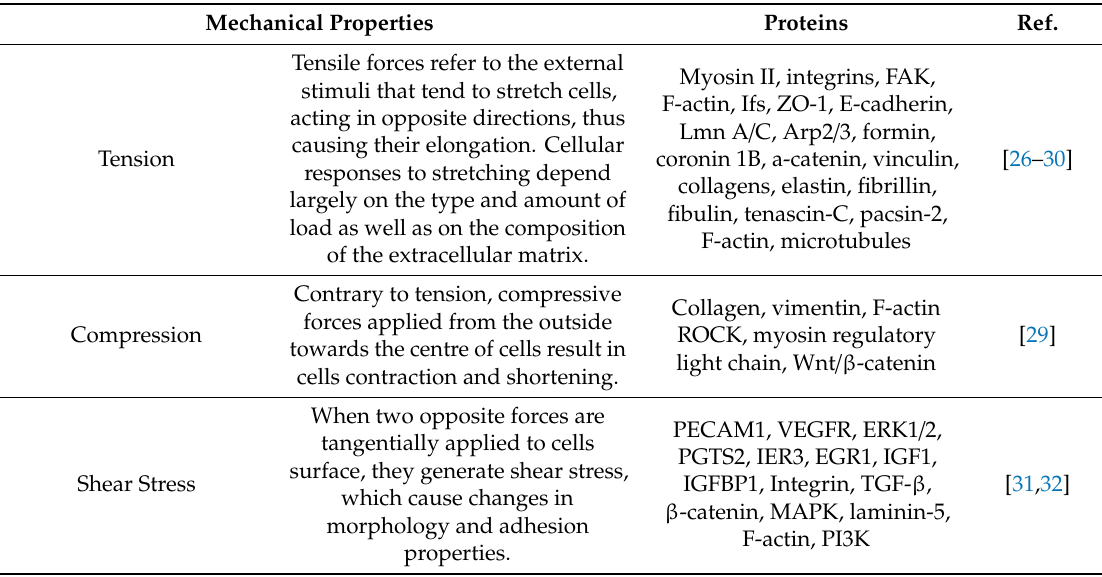
Table 1. Mechanical properties and biological